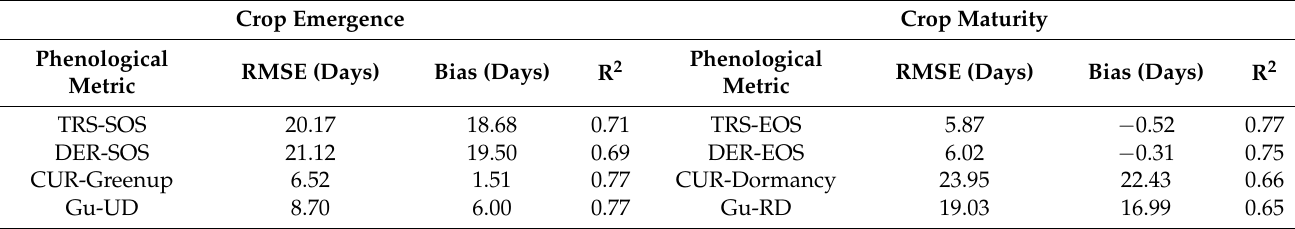
Table 2. The accuracy statistics of comparisons between the PhenoCam GCC-based transition date estimates and corresponding visual observations for all the corn and soybean